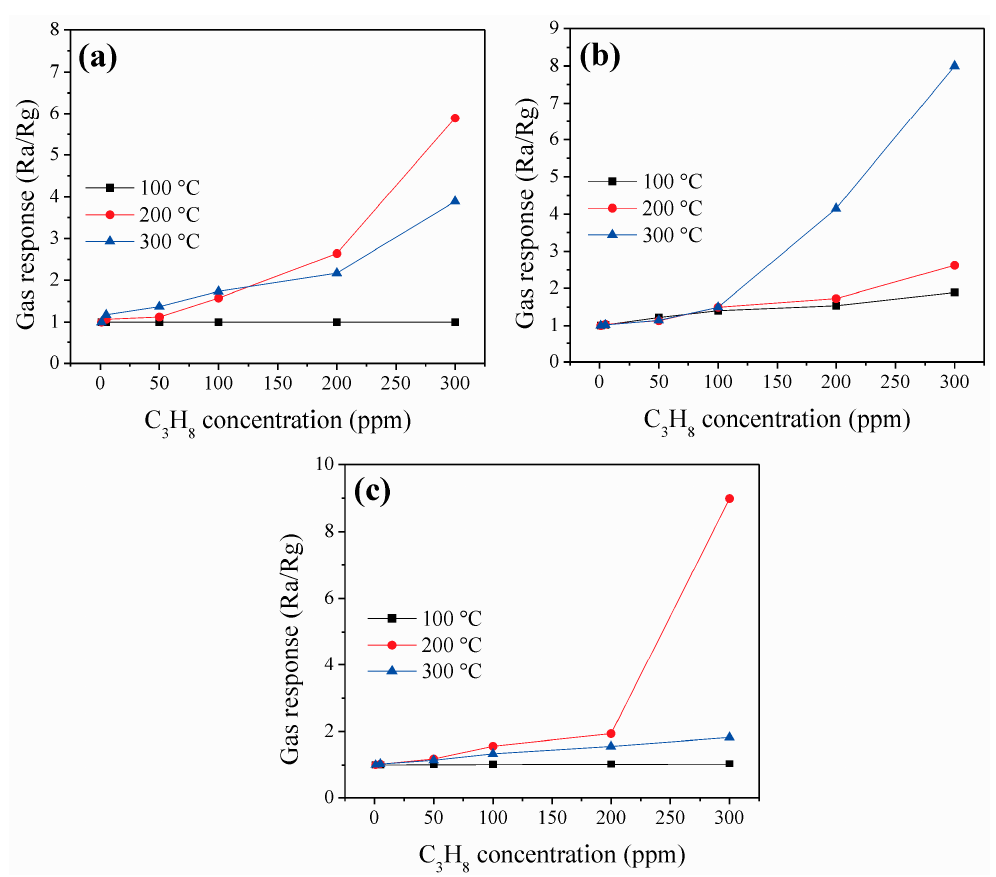
Figure 9. Response of the ZnCo 2 O 4 sensors as a function of C 3 H 8 concentration at different working temperatures: ( a ) sample A; ( b ) sample B; and ( c ) sample C.